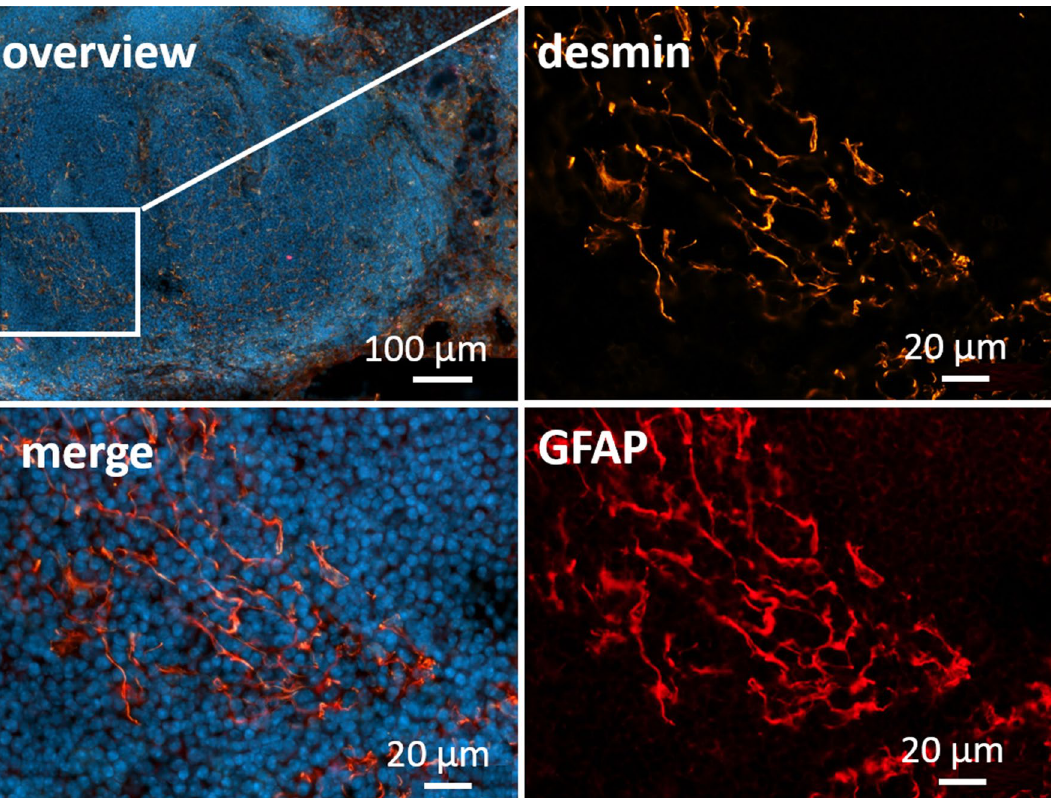
Figure 7. Mandibular lymph node co-stained with polyclonal anti-GFAP antibody (DAKO) in red and desmin in orange. DAPI for nuclear staining in blue. Desmin and GFAP signals are co-located throughout the